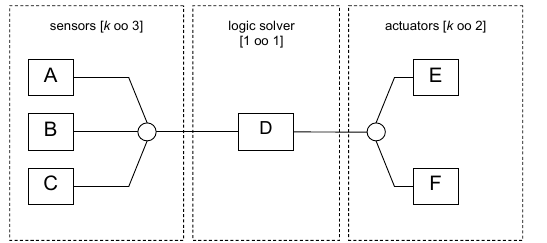
Figure 10. Example structure of the E/E/PE system (SIS or BPCS).